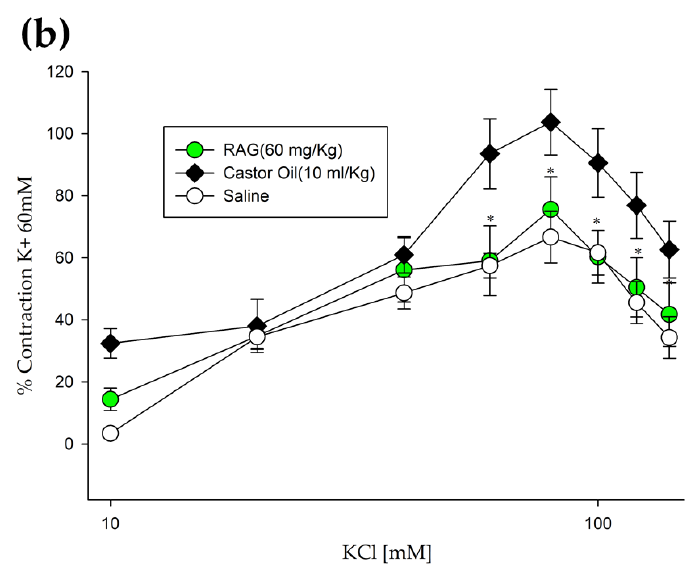
Figure 5. Ex vivo antispasmodic activity of RAG (60 mg / Kg). ( a ) Concentration–response curves of CCh demonstrating that oral administration of castor oil (10 mL / kg) significantly increased ( p < 0.05) the contractions in intestinal preparations (jejunum-ileum). However, tissues from animals treated with RAG did not show responses that di ff ered from those challenged with castor oil. ( b ) Intestinal preparations from mice pretreated with RAG 1 h before the castor oil challenge showed significantly lower contractile responses ( p < 0.05) in response to increasing KCl concentrations. Statistics: two-way ANOVA with Holm–Sidak multiple comparison test. Abbreviations: RAG = red angico gum; CCh = carbachol.